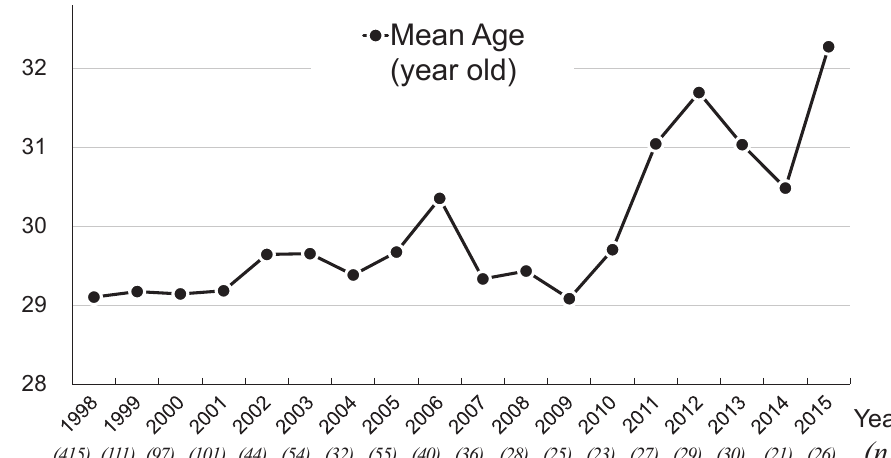
Figure 4. Annual trends in the mean age of participants, 1998 – 2015. The mean ages of participants are shown for each year of the study period (1998 – 2015). Each value given in parentheses under the calendar year represents the sample size in each year.